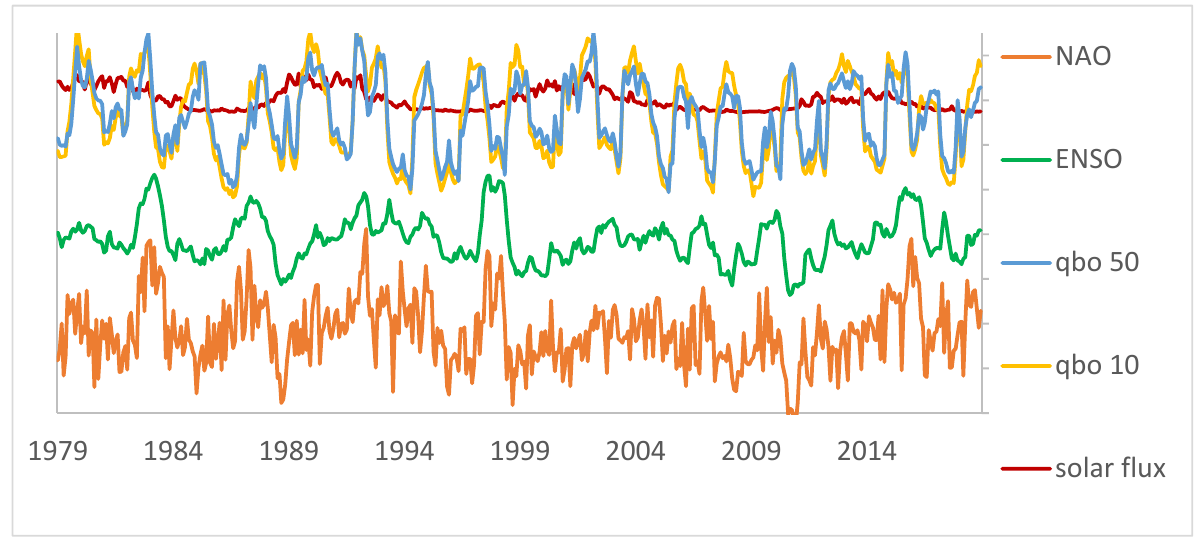
Figure 10. Time series of NAO, ENSO, F10.7 cm, and QBO at 10 and 50 hPa for period 1970–2019.